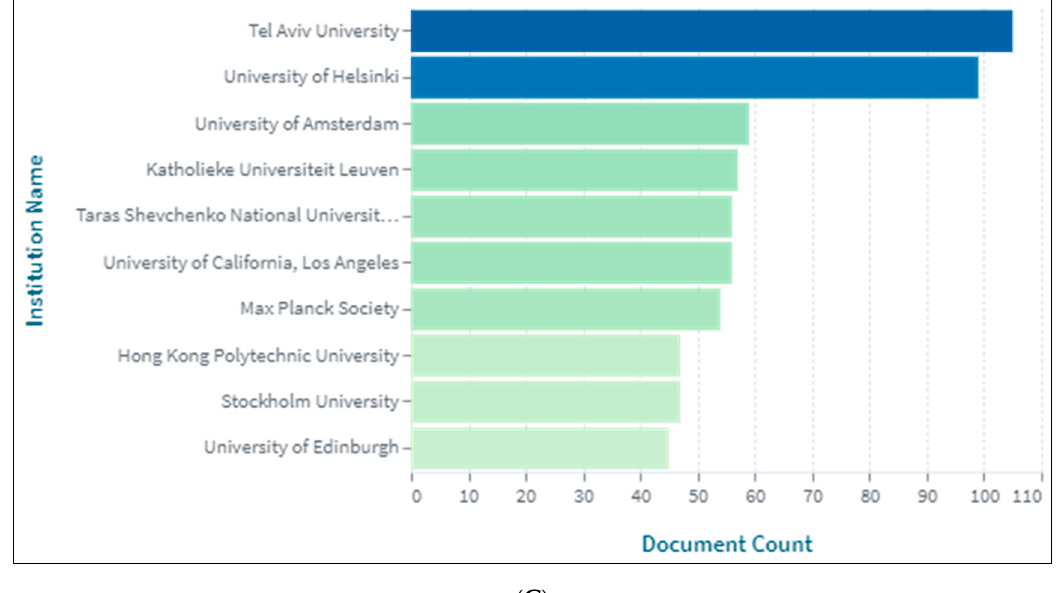
Figure 3. Pragmatics knowledge production size by university/research centre. ( A ) (Scopus). ( B ) (WOS). ( C ) (Lens).